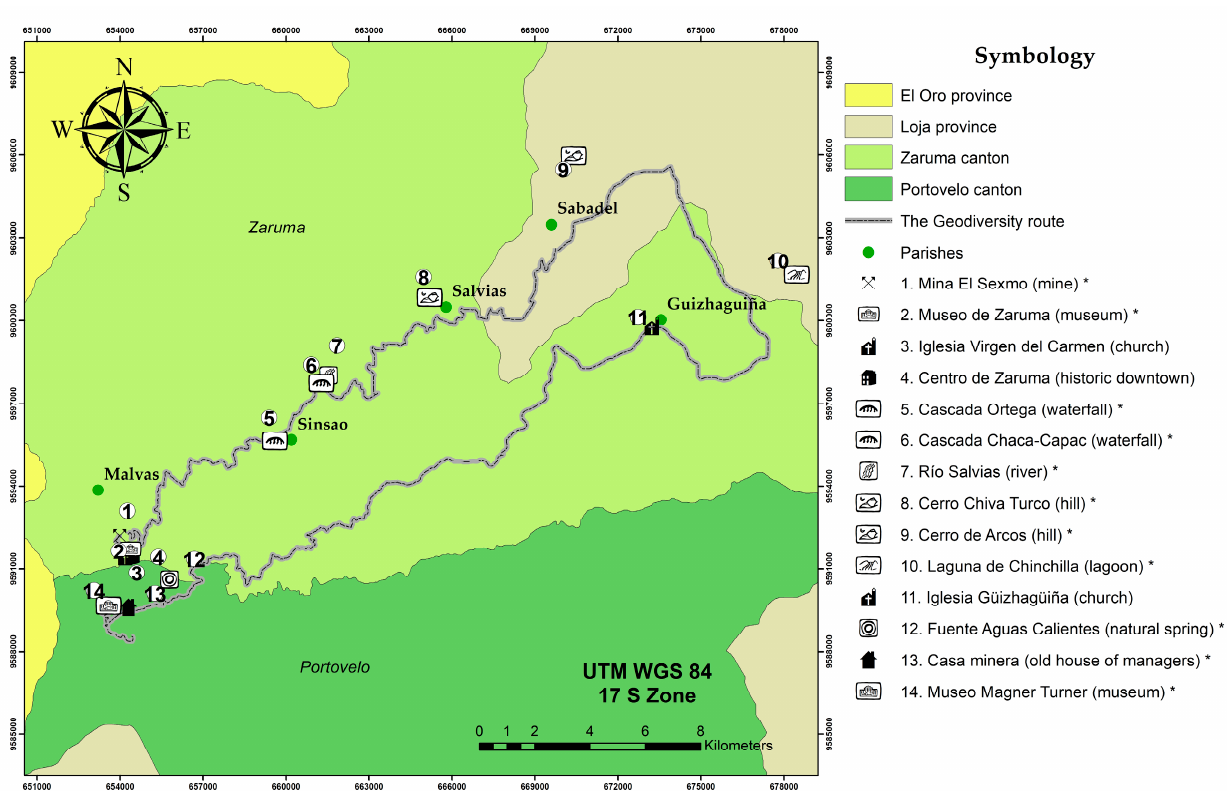
Figure 10. GtRAM evaluation of the sites that make up the new route proposed “La Geodiver- sidad” in this study. * Geosites/mining sites.